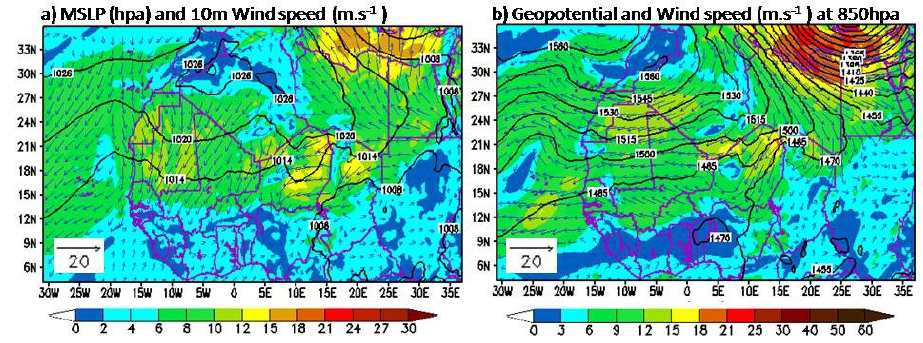
Fig. 9. Sandblasting mass efficiency ( α ) in m − 1 calculated by: (a) MaB95 with 0% < clay < 20% and (b) Shao et al. (1996).